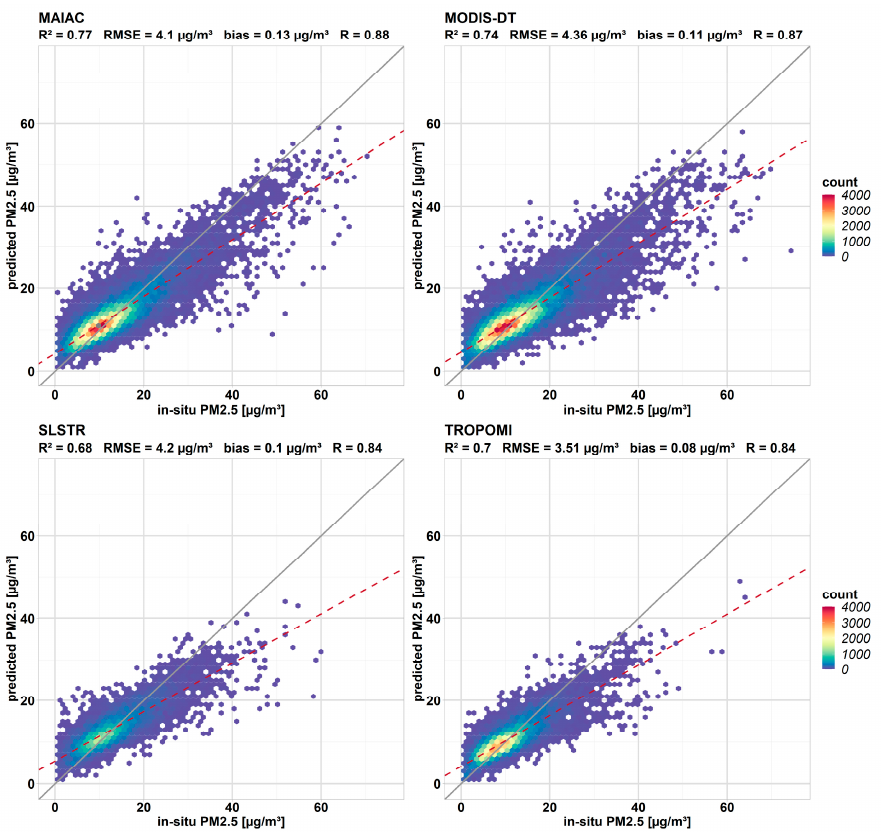
Figure 1. Cross-validated PM 2.5 predictions from the random forest models plotted against the observational PM 2.5 data for all station–satellite collocations in 2018. Dotted red lines represent the regression lines. Table 4. Overall and seasonal CV PM 2.5 statistics for the different datasets including the number of samples (N), the coefficient of determination (R 2 ), the Pearson correlation coefficient (R), root mean square error (RMSE) and mean